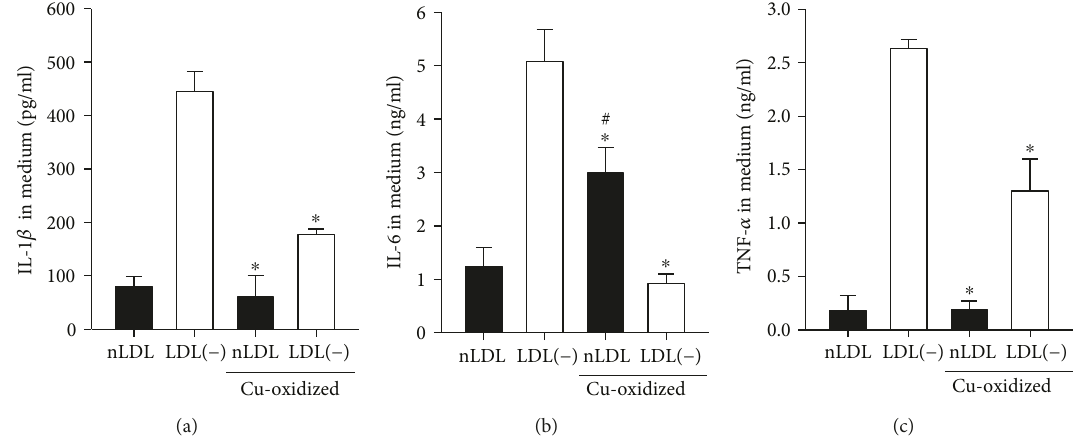
Figure 5: E ff ects of copper oxidation of nLDL and LDL(-) on IL-1 β , IL-6, and TNF- α production in THP-1 macrophages. THP-1 macrophages were treated with 20 μ g/ml of nLDL, LDL(-), Cu-ox-nLDL, or Cu-ox-LDL(-) for 24 h, then levels of IL-1 β (a), IL-6 (b), and TNF- α (c) in the medium were measured by ELISA. Values are the mean ± SD of three independent experiments. ∗ p < 0 05 , compared to LDL(-)-treated